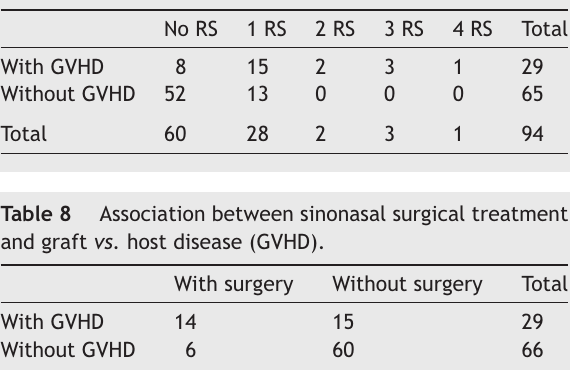
Computed tomography (CT) of the paranasal sinuses findings.